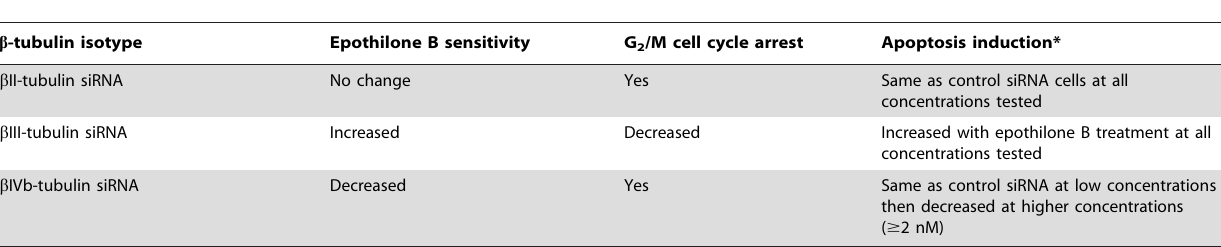
Table 1 . Summary of the differential response of b -tubulin isotypes to epothilone